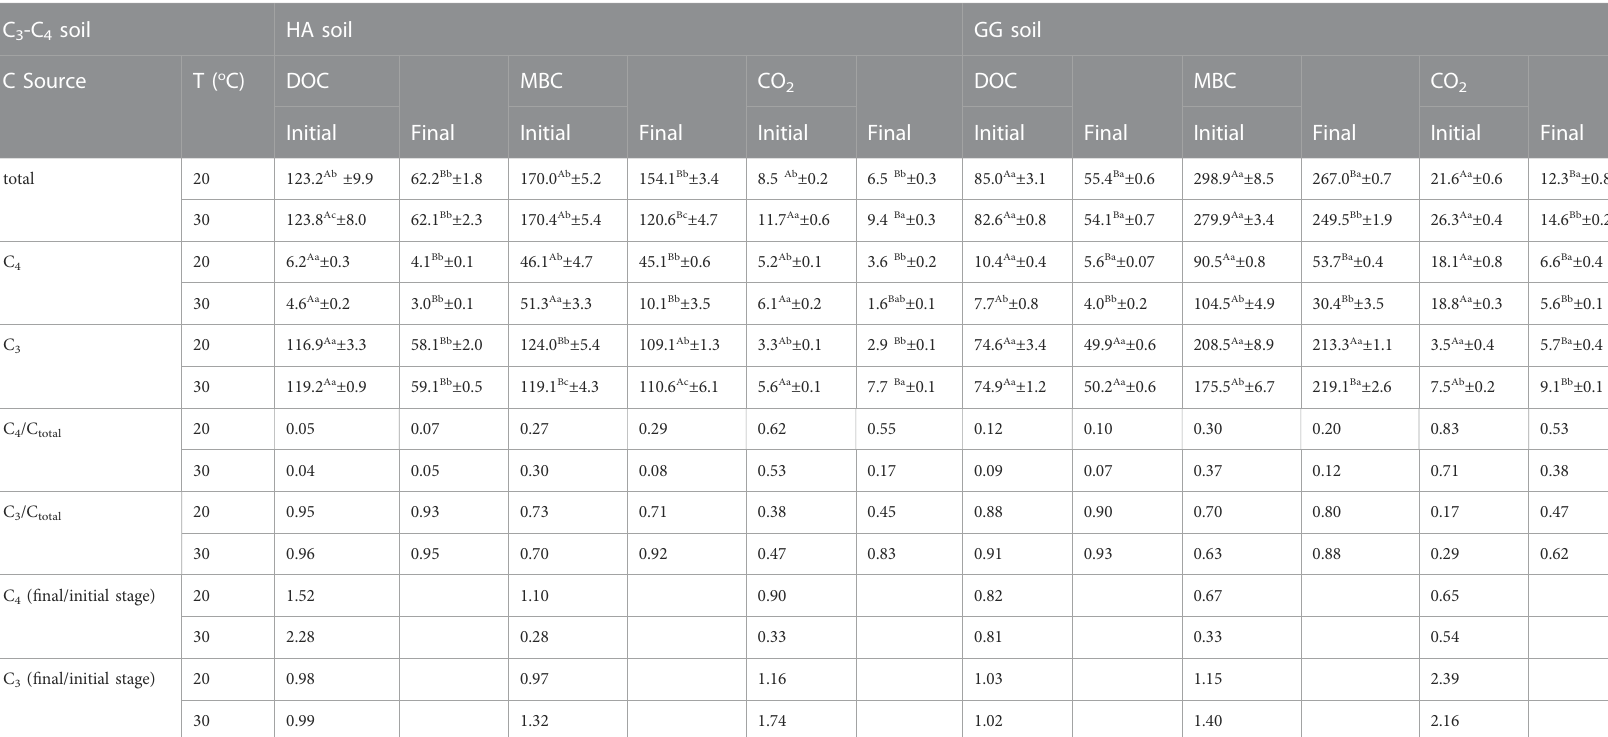
TABLE 1 The contribution of aSOC (C 4 ) and dSOC (C 3 ) to CO 2 -C ( μ gCO 2 -C g − 1 soil d − 1 ), MBC ( μ g C g − 1 soil) and DOC ( μ g C g − 1 soil) at the initial 45d and the fi nal 45d stages of incubation. Values are means ± standard errors ( n = 3). Values with different lowercase letters in each column and capital letters in each row are signi fi cantly different ( p < 0.05). T: incubation temperature ( o